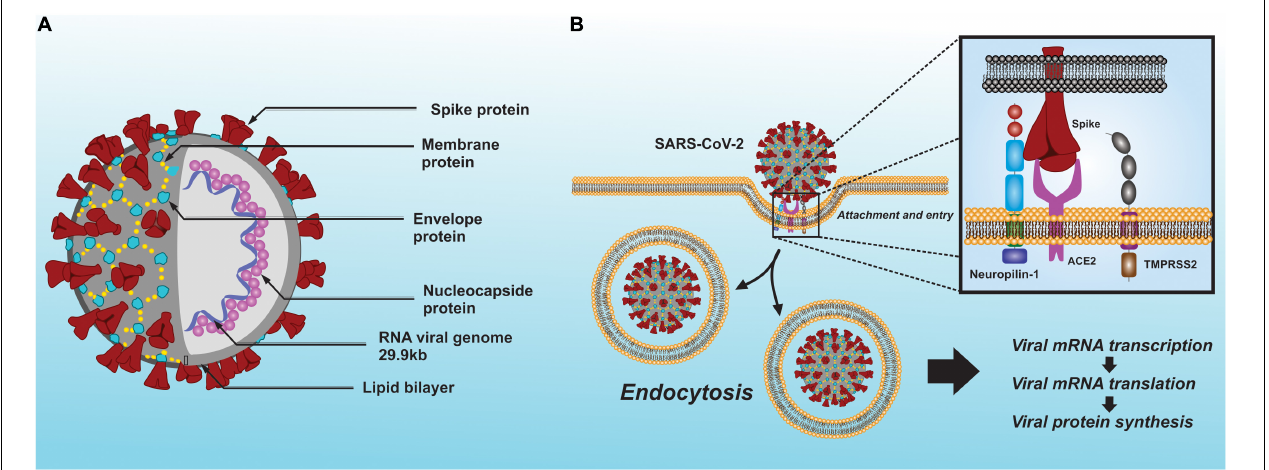
FIGURE 1 | Schematic model of the SARS-CoV-2 whit its structural proteins. (A) The virus envelope is associated with four structural proteins: membrane protein (M); spike protein (S); envelope protein (E); and nucleocapsid protein (N). Moreover, it has a single-stranded positive sense RNA and a genome approximately 29.9 kb in size. (B) To enter a host cell, the SARS-CoV-2 spike protein interacts with the ACE2 and neuropilin-1, while TMPRSS2 to activate its membrane-fusion capacity and subsequent